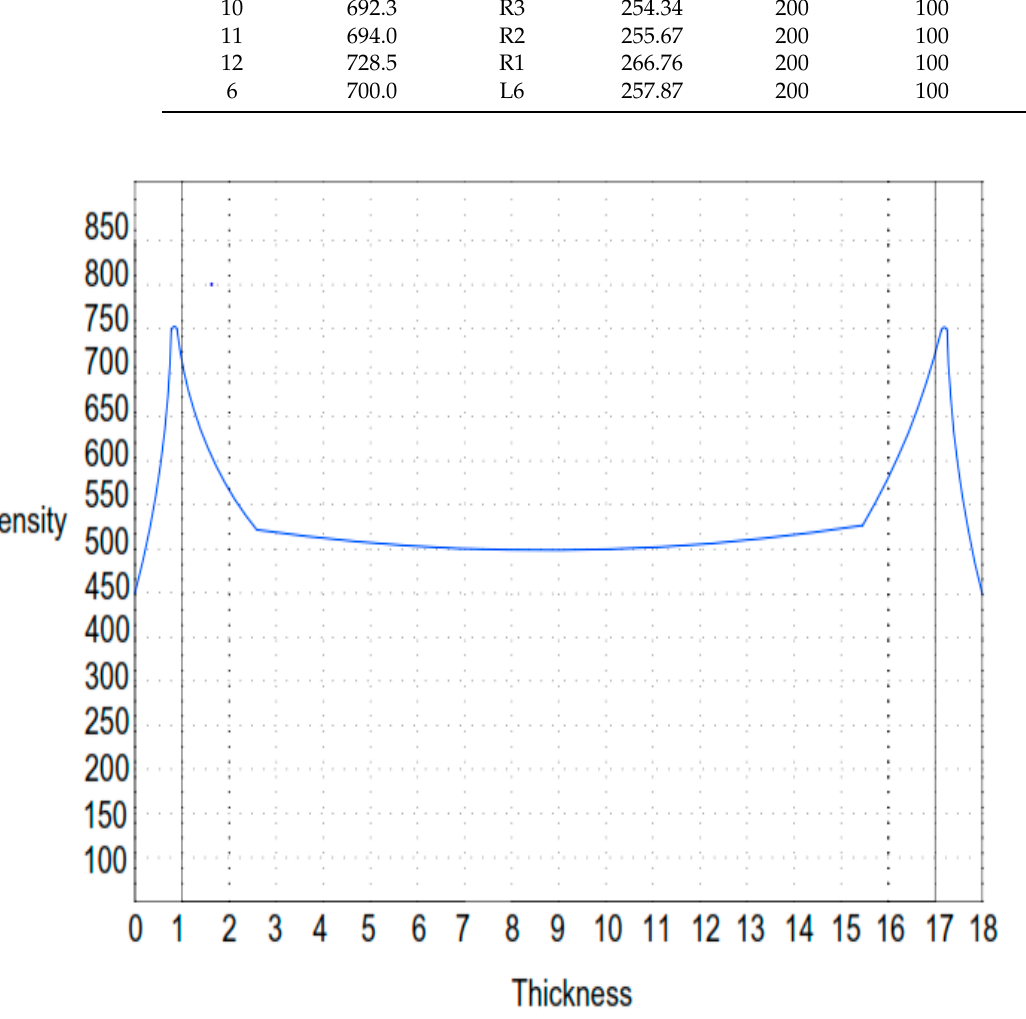
Figure 11. X-ray vertical density profile of 4thspecimen. Table 17. Bending